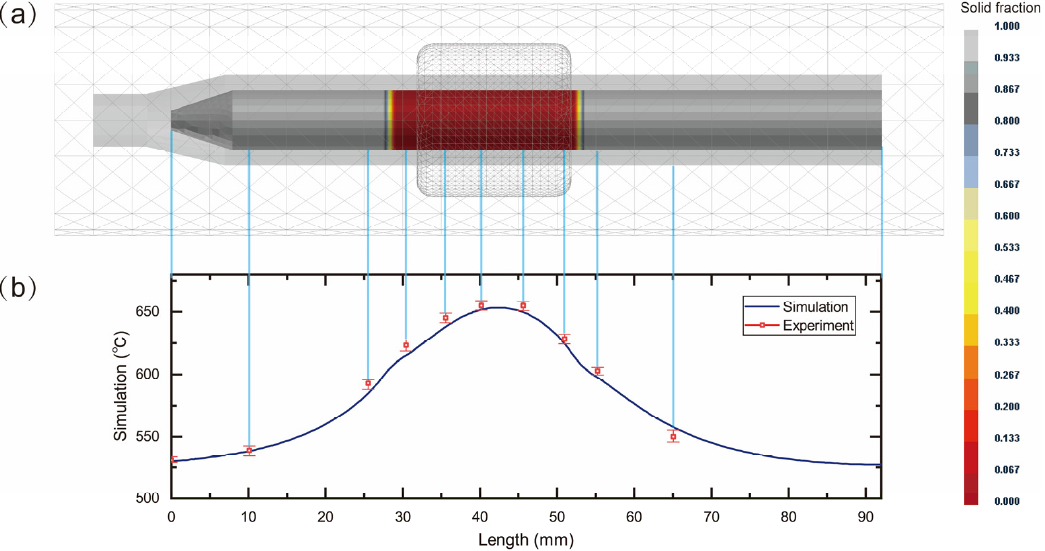
Figure 2. Temperature field modeling and experimental verification. ( a ) Solid phase fraction simu- lation during the zone melting process, the red part is the melting zone, ( b ) simulated temperature distribution and experimental temperature distribution.